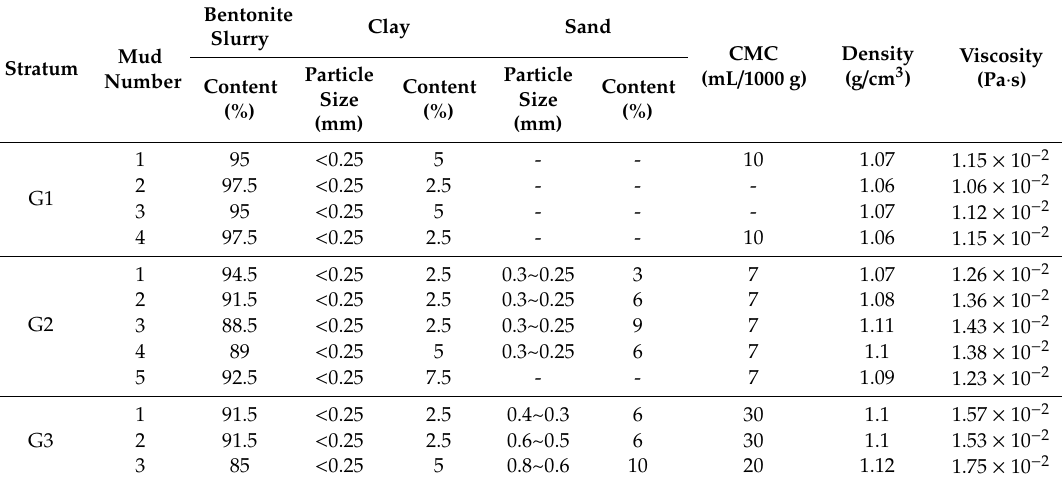
Table 2. Stratum